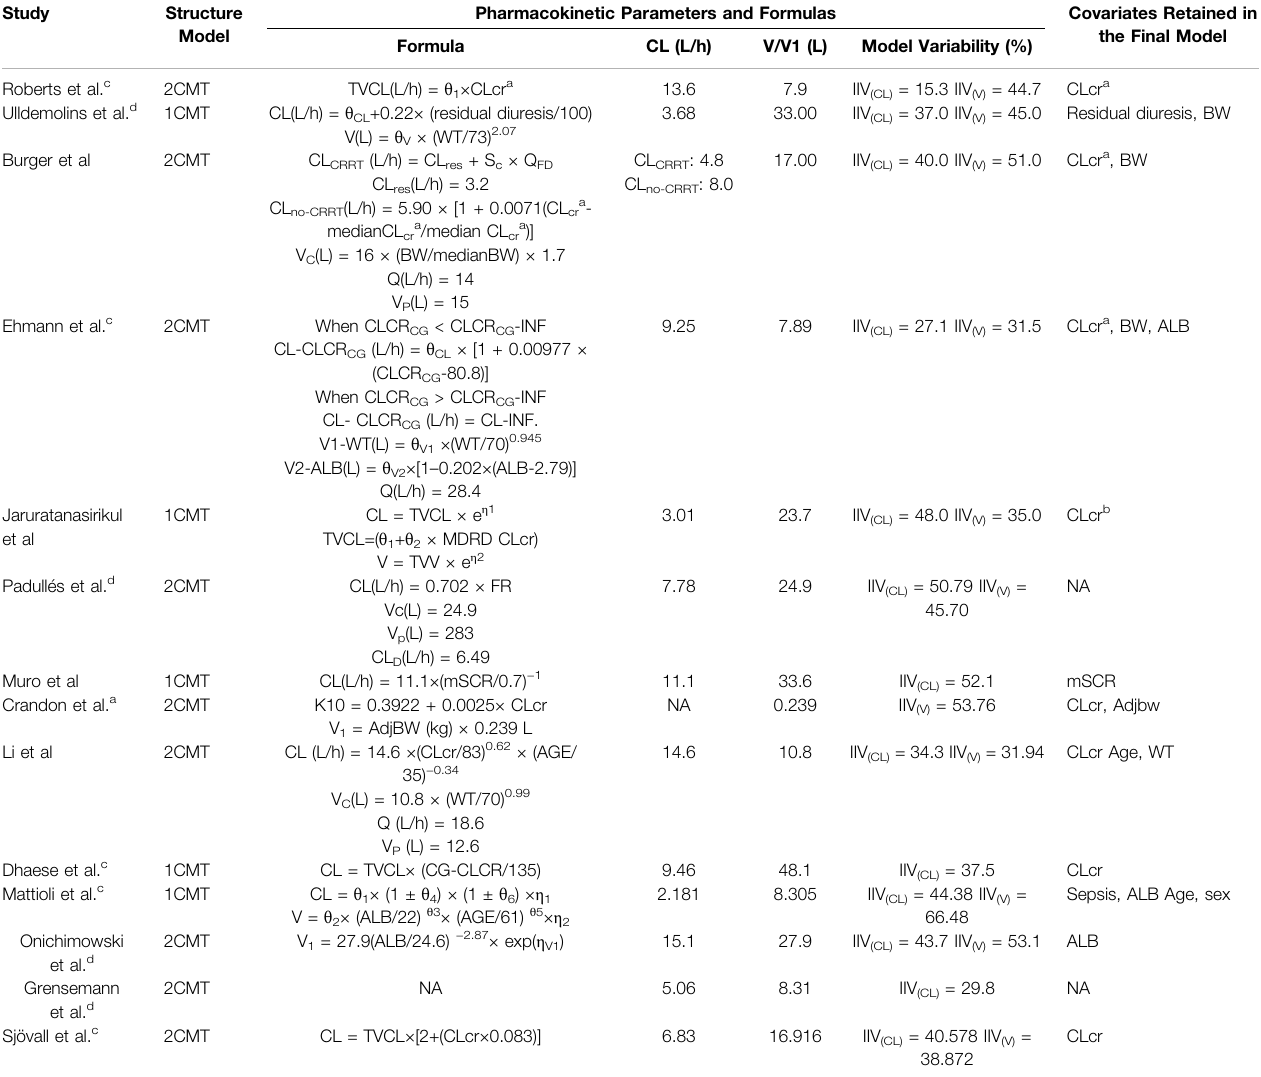
TABLE 2 | Summary of published population pharmacokinetic studies of meropenem in critically ill